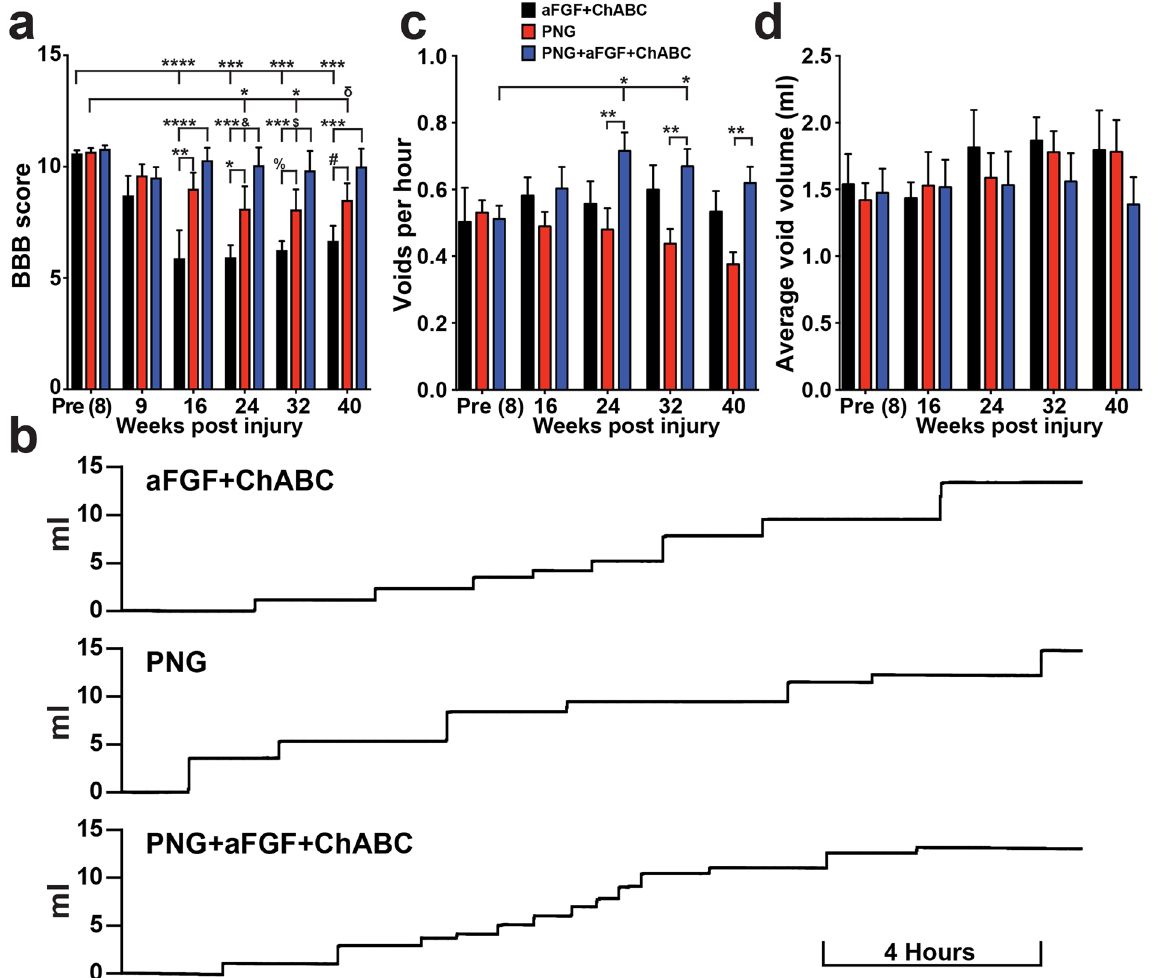
Figure 7. PNG + aFGF + ChABC treatment maintains locomotor and improves micturition patterns. ( a ) Locomotor BBB score of rats prior to the repair surgery (Pre (8)) and following the repair surgery (weeks 9–40). n = 6 per group except at week 9 n = 5 for PNG and aFGF + ChABC. Between groups: & p = 0.0640, $ p = 0.0931, % p = 0.0816, # p = 0.0794, * p < 0.05, ** p < 0.01, *** p < 0.001, **** p < 0.0001 Two-way repeated measures ANOVA Fisher’s Least Significant Difference post-hoc test. Within group δ p = 0.0582, * p < 0.05, *** p < 0.001, **** p < 0.0001 One-way ANOVA, Fisher’s Least Significant Difference post-hoc test. ( b ) Representative smoothed metabolic cage traces 40 weeks after injury. ( c , d ) Metabolic cage quantification of average void frequency ( c ) and void volume ( d ). n = 6 per group. Between groups: ** p < 0.01. Two-way repeated measures ANOVA, Fisher’s Least Significant Difference post-hoc test. Within group * p < 0.05 One-way ANOVA, Fisher’s Least Significant Difference post-hoc test. Data represent mean ±